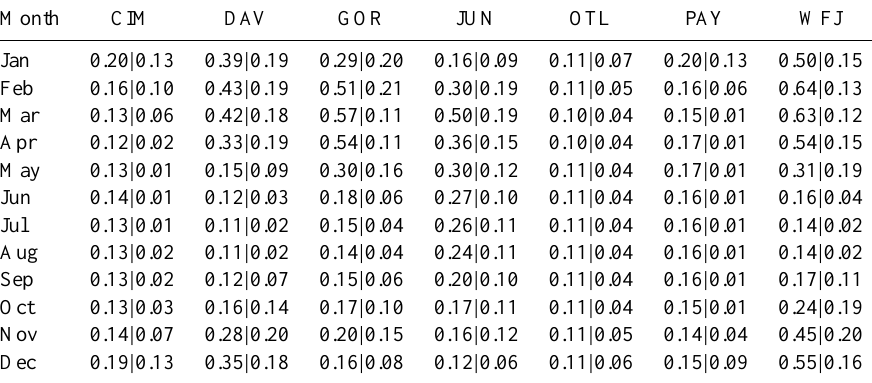
Table B1. Mean and standarddeviation ( µ | σ ) of the ground albedo from the MODIS/Terra+Aqua BRDF and Calculated Albedo data set, estimated at each location for a surrounding terrain of approximately 6 . 5 2 km 2 for each month of the